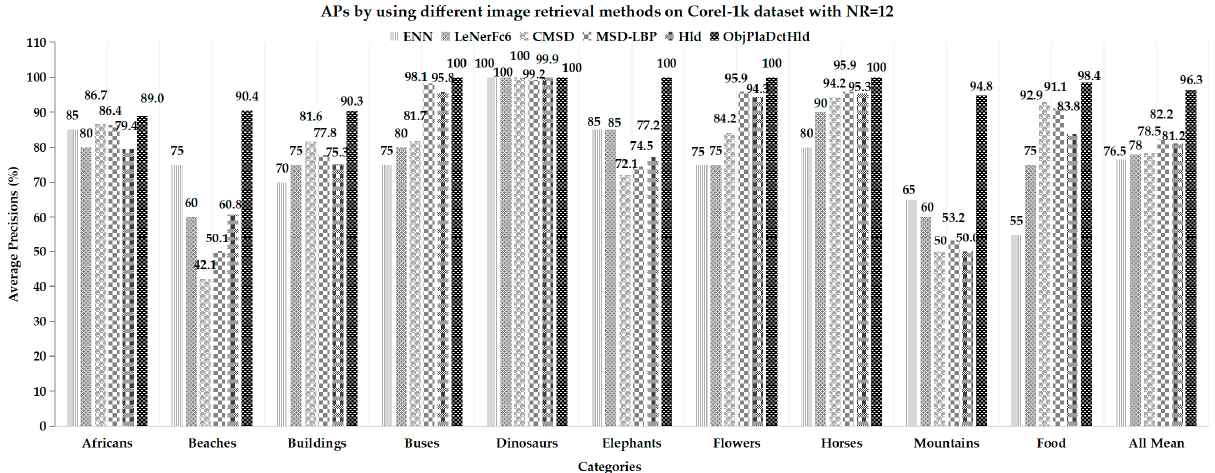
Figure 7. Bar plot of APs by using different image retrieval methods (Top NR = 12) on Corel-1k dataset.